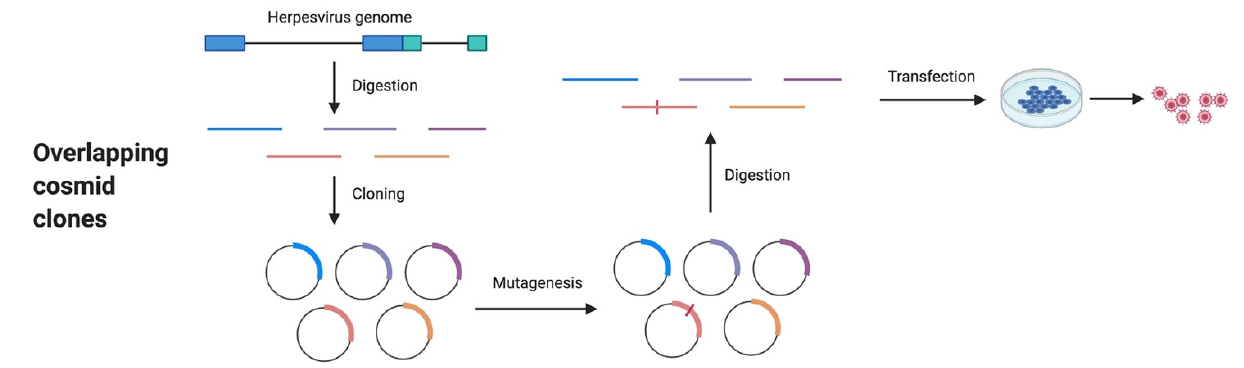
Figure 3. Generation of overlapping cosmid clones and their application to herpesvirus mutagenesis.